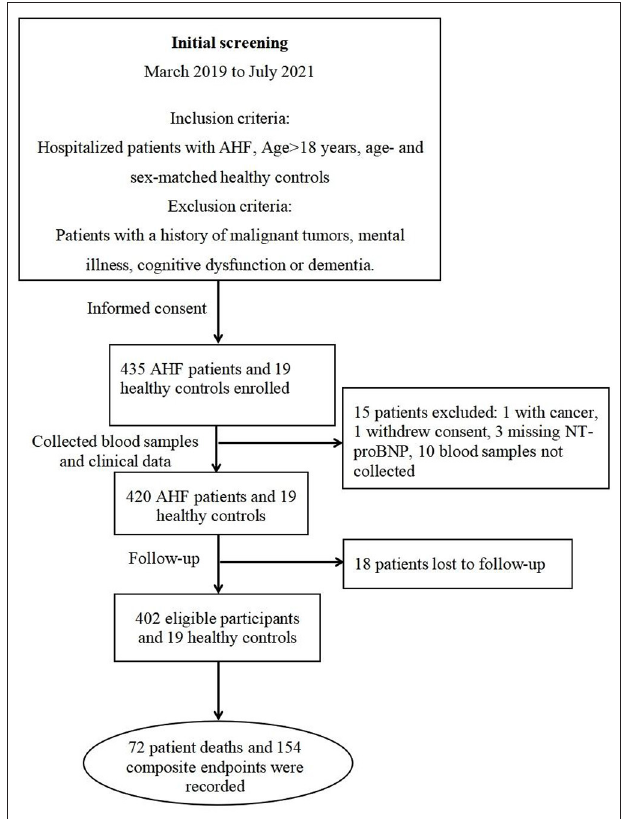
FIGURE 1 | Flow chart of the study and outcome for the AHF cohort. AHF, acute heart failure.